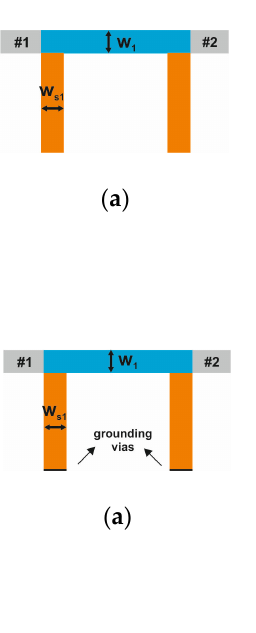
( d ) Figure 3. ( a ) A bandpass filter circuit by using square loop resonator ( b ) TL model ( c ) LE model ( d ) frequency response. ( a ) ( d ) Figure 4. ( a ) A bandpass filter circuit by using a square loop resonator with perturbation element ( b ) TL model ( c ) LE model ( d ) frequency response. Figures 5 and 6 show the geometry formed by the combination of the stubs and square loop resonator, which is located on a main transmission line connecting the I/O ports. It should be noted that the circuits are symmetrical according to the TT ′ plane. Such configurations are called unit filter cells in this paper. Figures 5a and 6a show the two different topologies of the unit filter cell. TE and LE equivalent circuits corresponding to these topologies are given in Figures 5b, 6b and 5c, 6c, respectively. The frequency re- sponses of the unit filter cells are shown in Figures 5d and 6d. Accordingly, a multi-mode two-band bandpass filter may be designed by using the unit cell configuration having the two-band characteristic given in Figure 6a. Even-odd mode analysis, which is a widely used method in the literature [17,18], is performed for the unit filter cell to describe the design method of the two-band bandpass filter. For this purpose, the unit filter cell having the two-band characteristic given in Figure 6a is first analyzed through even-odd mode impedance analysis. Due to the reciprocal topology, even-odd mode analysis can be used on the symmetry plane TT ′ to investigate the behavior of the unit cell. The TL and LE equivalent circuit models of the proposed unit filter cell are illustrated in Figures 6b and 6c, respectively. To analyze the circuit, even- and odd-mode half circuits can be obtained by placing magnetic and electric walls to the symmetry axis TT ′ in the TL model, respec- tively. Thus, the symmetry axis must be open- and short-circuited for the even and odd modes, as illustrated in Figures 7a and 7b, respectively.